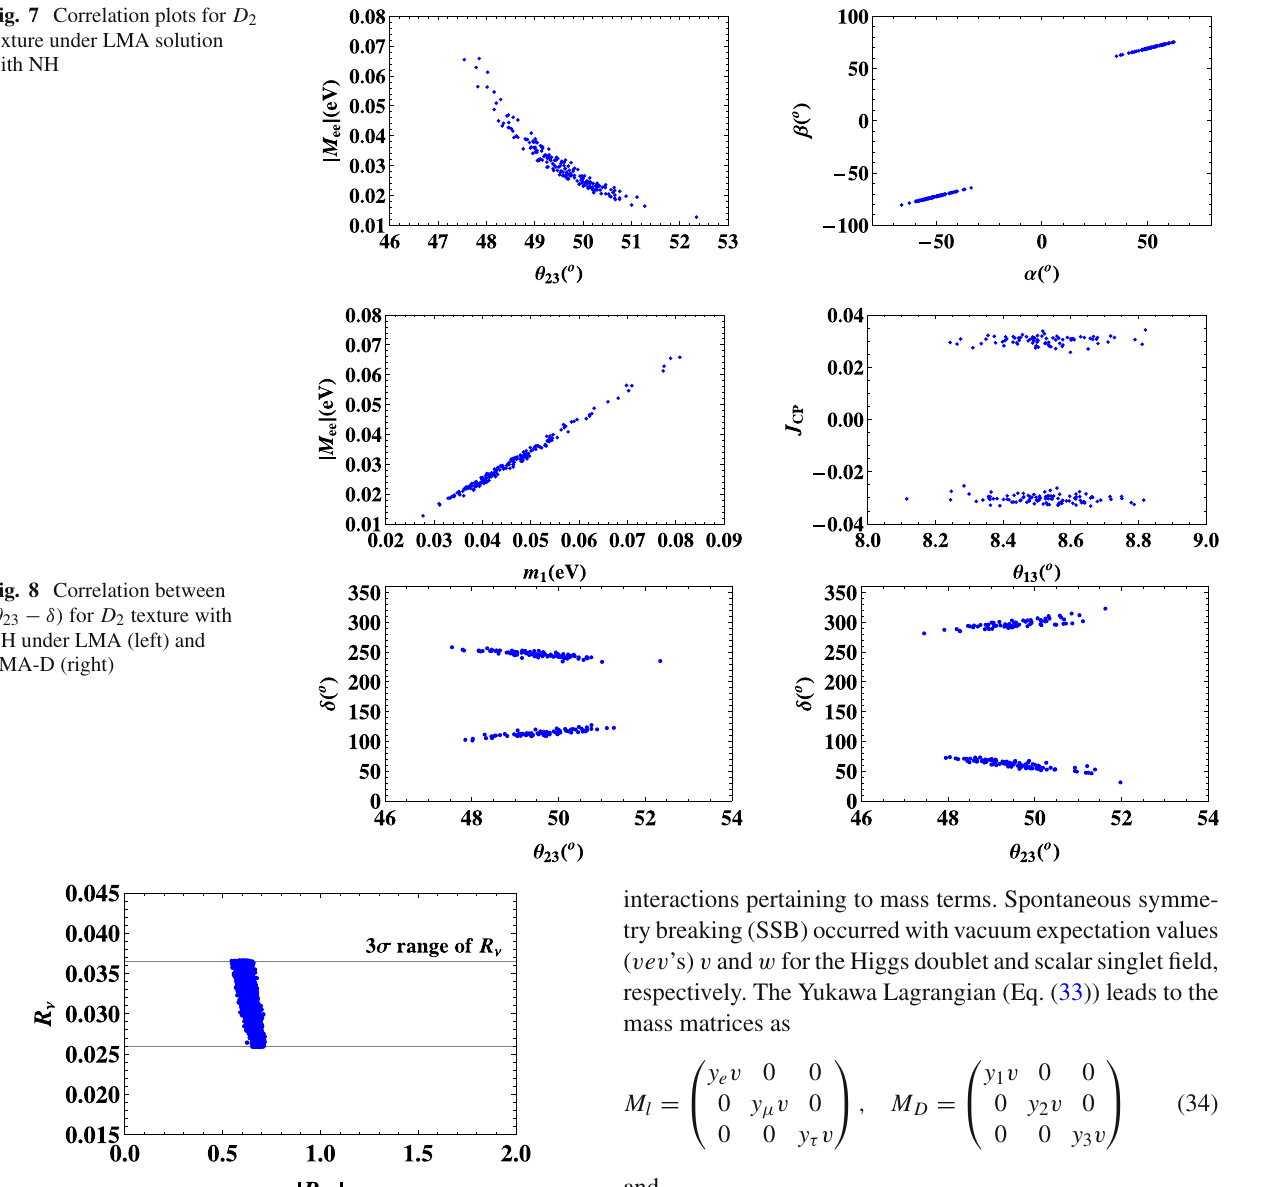
Fig. 7 Correlation plots for D 2 texture under LMA solution with NH